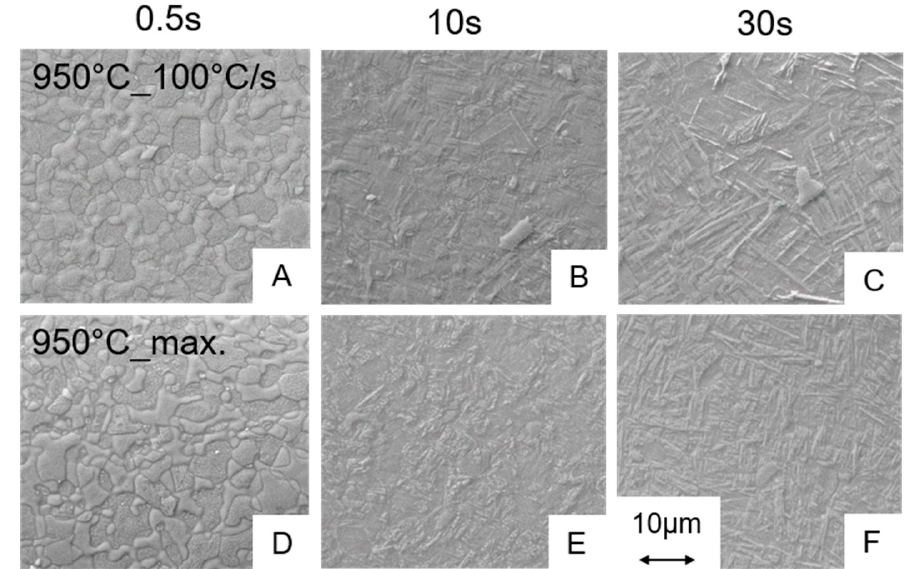
Figure 7. SEM images of the microstructures for the experiments at 950 ◦ C for holding times of 0.5, 10 and 30 s in combination with controlled cooling with 100 ◦ C / s ( A – C ) and with the maximum cooling rate ( D – F ). The heating rate was 1000 ◦ C / s.